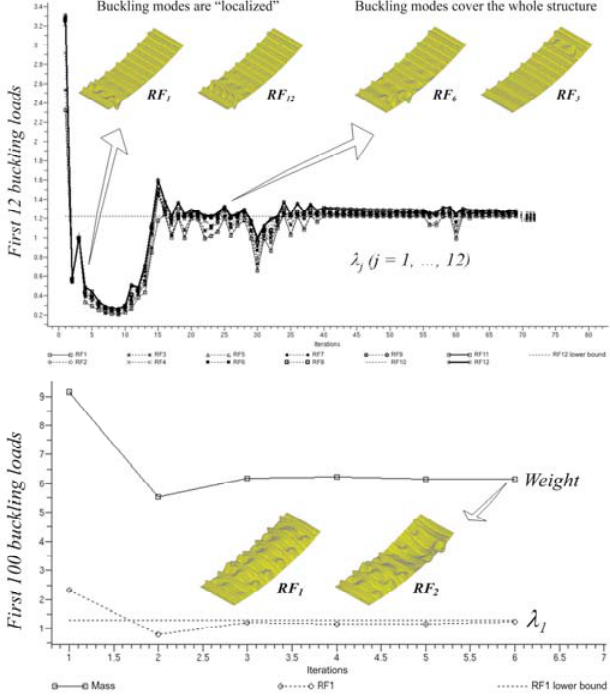
Fig. 9. Convergence history for 12 and 100 buckling